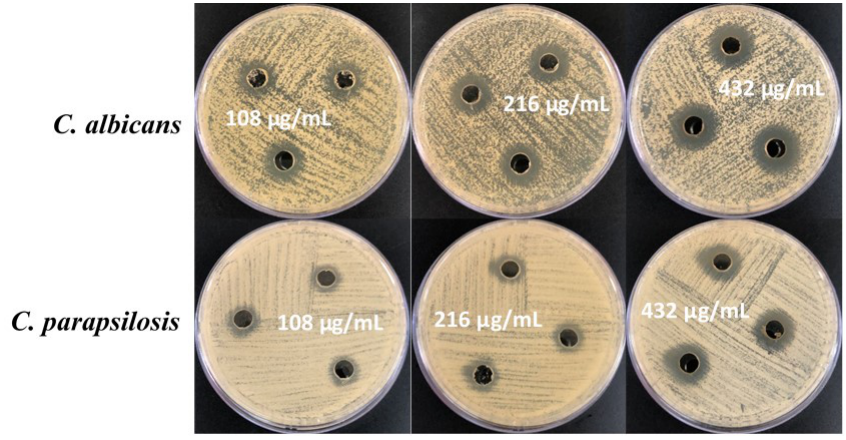
Figure 9. Produced zones of inhibition of C-AgNPs against C. albicans and C. parapsilosis at three different concentrations, 108, 216, and 432 µg/mL, respectively.